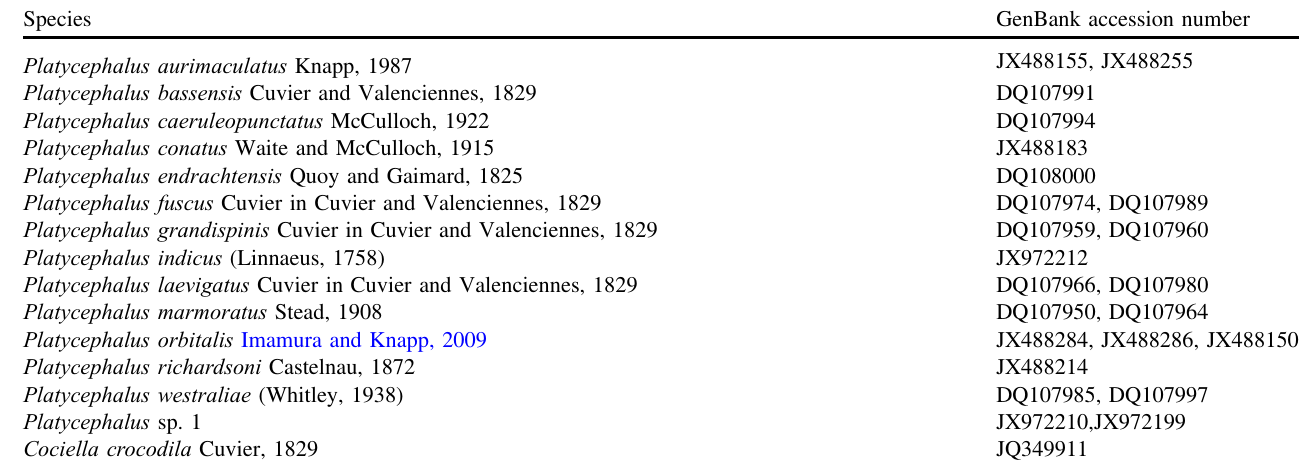
Table 1. GenBank accession numbers of related COI sequences downloaded from NCBI for phylogenetic tree study. No COI sequences of Platycephalus cultellatus were found in